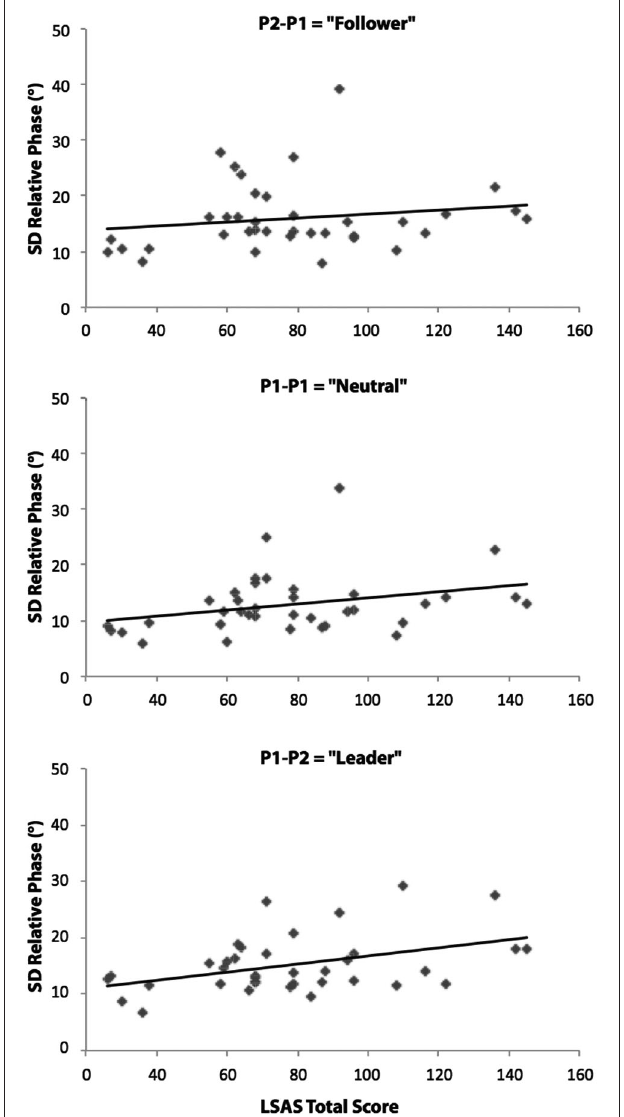
FIGURE 3 | Relationships between LSAS Total scores (SAD patients and matched control participants ) and the relative phase standard deviations (average of the two phase patterns) for the P2-P1 (Follower), P1-P1 (Neutral) and P1-P2 (Leader) pendulum conditions . Correlational analyses revealed significant positive linear relationships in P1-P1 and P1-P2 conditions ( p < 0.05). The diagonal on the figures indicates the line of best